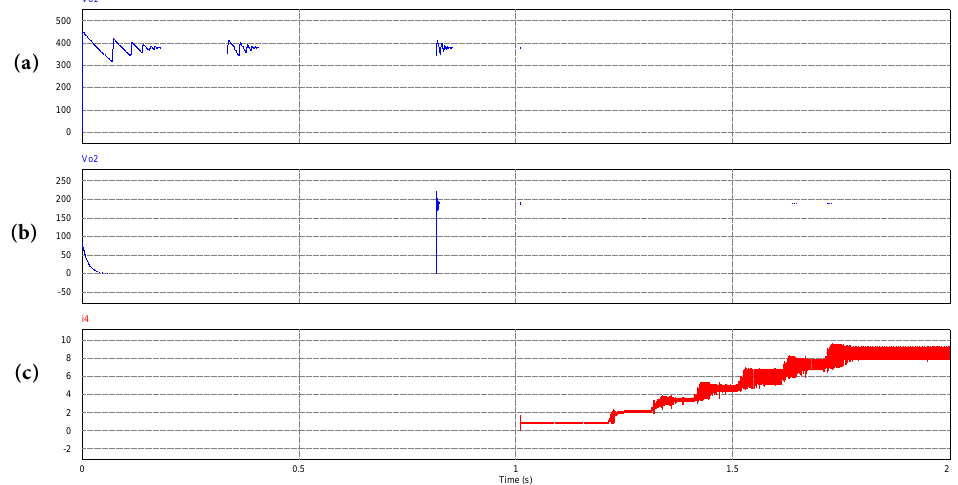
Figure 31. Fifth set of simulation results, ( a ) primary DC bus, ( b ) 1.2 kW converter output voltage and ( c ) 400 W converter current output.